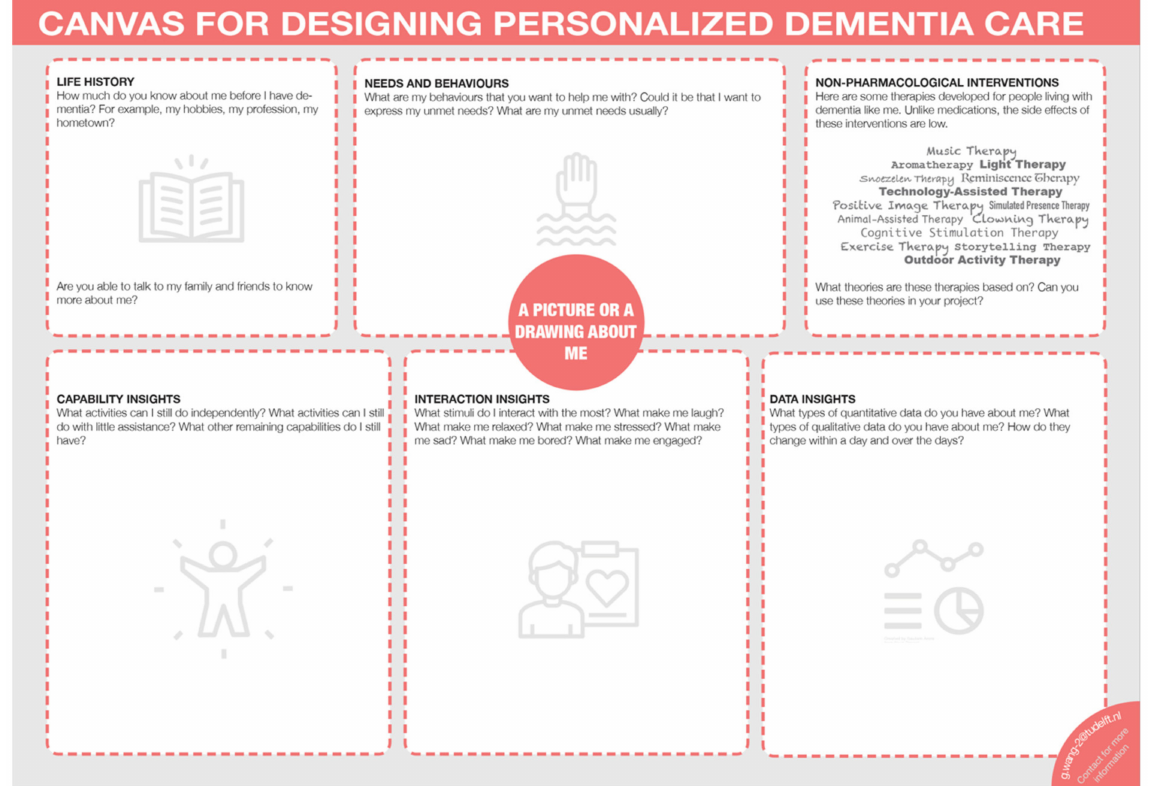
Figure 7. Template of the person-centred